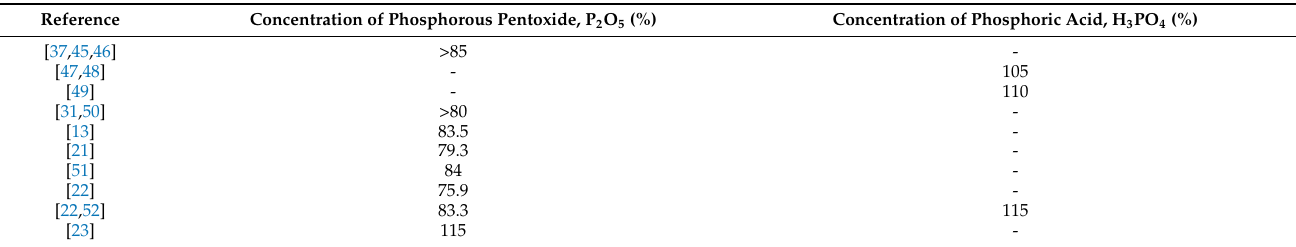
Table 3. Properties of PPA based on previous studies.